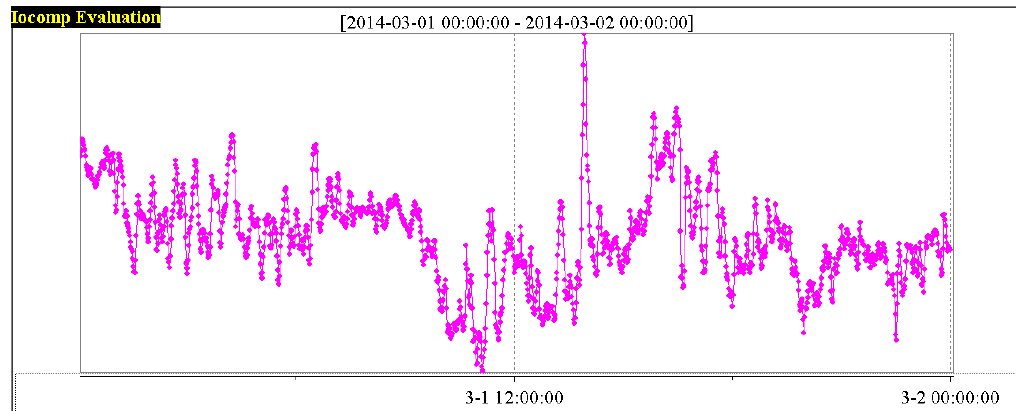
Figure 6. The carbon content of fly ash